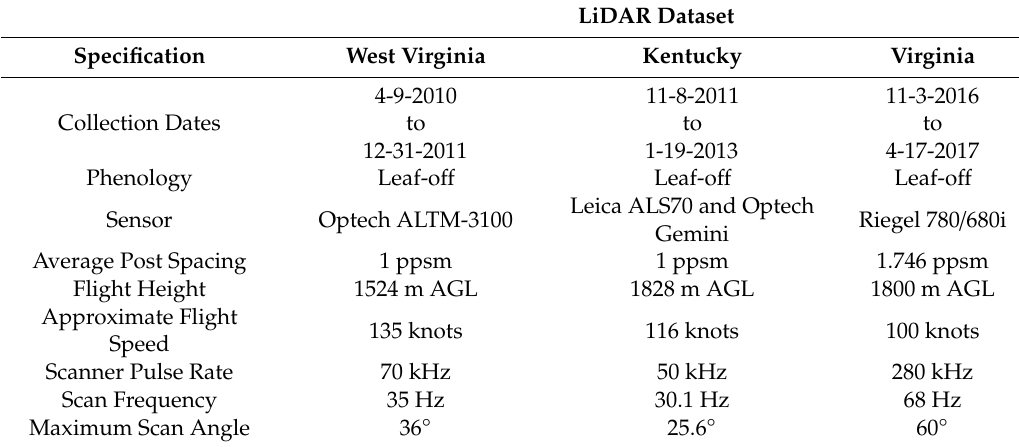
Table 2. Description of LiDAR